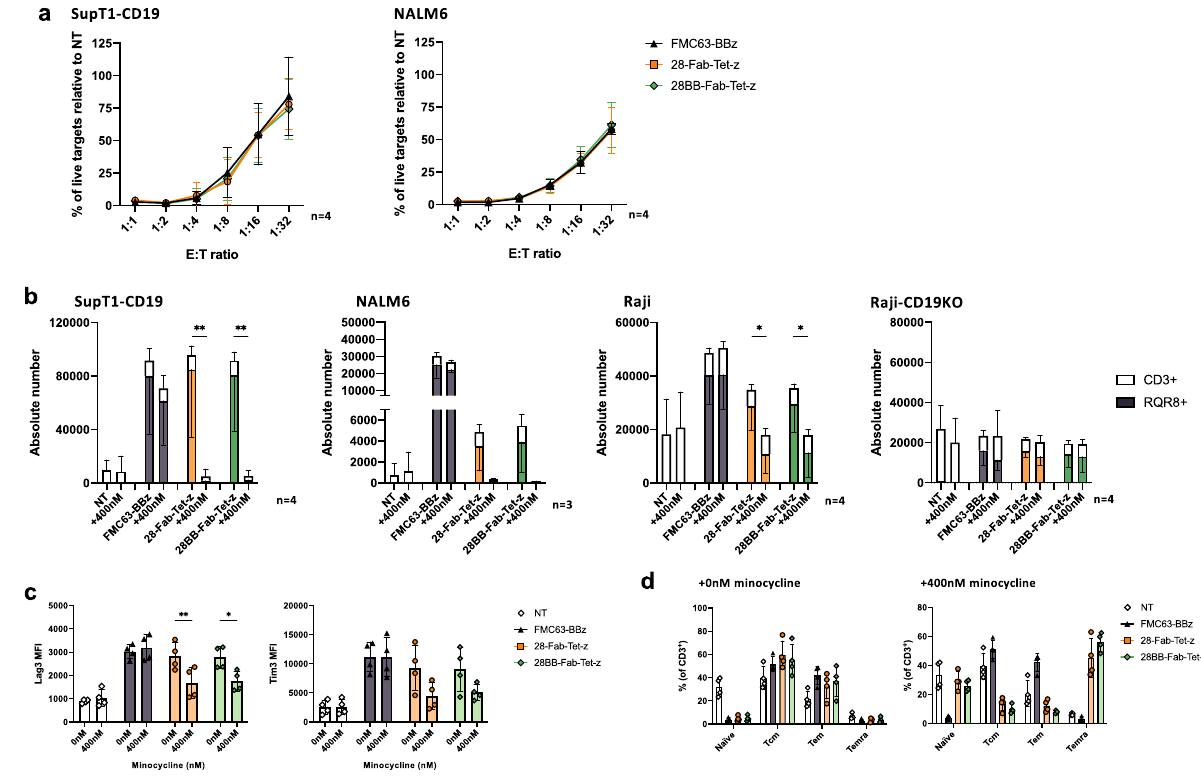
Figure 5. Effector function of CD28-containing TetCAR matches 41BBζ control CAR. ( a ) Killing of SupT1- CD19-GFP after 24 h or NALM6 after 48 h of co-culture with CAR-T cells at 1:1–1:32 E:T ratio. Data shows mean ± SD, n = 4 donors from 2 independent experiments. ( b ) SupT1-CD19, NALM6, Raji or Raji-CD19KO targets were incubated with mitomycin C, then co-cultured with CAR-T cells at 1:2 E:T ratio for 7 days. To relevant wells, 400 nM of minocycline was added on day 0. Graphs show mean (± SD) number of RQR8 + T cells (filled bars) or total CD3 + T cells (white bars) for each target. n = 4 donors (SupT1-CD19, Raji and Raji- CD19KO) or n = 3 (NALM6) from 2 independent experiments. Statistical analysis was through a two-way ANOVA comparing mean RQR8 number in each group ± minocycline (with Šidák’s multiple comparisons). P values for SupT1-CD19 were 28-Fab-Tet-z (**, 0.0028) and 28BB-Fab-Tet-z (**, 0.0050). P values for Raji were 28-Fab-Tet-z (*, 0.0320) and 28BB-Fab-Tet-z (*, 0.0304). ( c ) Mean fluorescent intensity of Tim3 and Lag3 after 7 days coculture with SupT1-CD19 targets, ± 400 nM minocycline. Data shows geometric mean (± SD) in CD3 + T cells. n = 4 donors, from 2 independent experiments. Statistical analysis was through a two-way ANOVA comparing each group ± minocycline (with Šidák’s multiple comparisons). P values for Lag3 expression were 28-Fab-Tet-z (**, 0.0078) and 28BB-Fab-Tet-z (*, 0.0207). ( d ) Percentage of naïve (CD62L + , CD45RA + ), Tcm (central memory; CD62L + , CD45RA - ), Tem (effector memory; CD62L - , CD45RA - ) or Temra